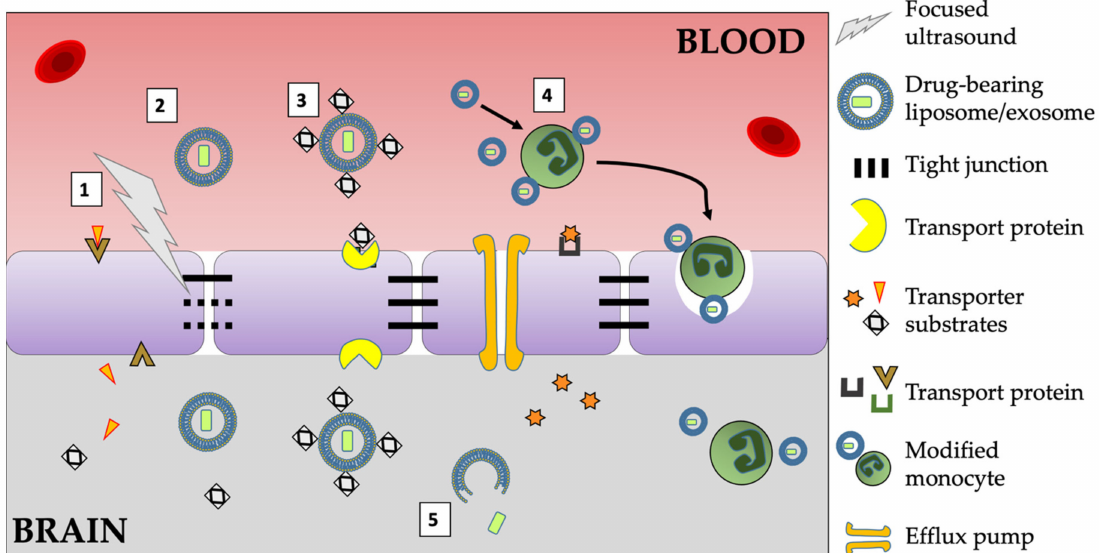
Figure 1. Common routes of nanomedicines targeting brain tumor drug delivery. A schematic diagram (not to scale) shows four main routes by which nanocarriers improve drug delivery to the brain parenchyma. 1. Focused ultrasound weakens endothelial tight junctions and improves uptake of nanocarriers. 2. Liposome passage through the intact BBB occurs, but only at low rates. Exosomes show higher penetration. Both may be enhanced by leaky tumor vasculature known as the enhanced permeability and retention (EPR) effect. 3. Liposomes can be modified with transporter substrates such as glucose, transferrin or glutathione to improve BBB crossing. 4. Liposomes targeting circulating cells capable of BBB penetration, known as the “Trojan Horse” approach. 5. Drugs must eventually leave the liposome in order to act on their targets. However, efflux pumps are capable of removing many drugs from the brain